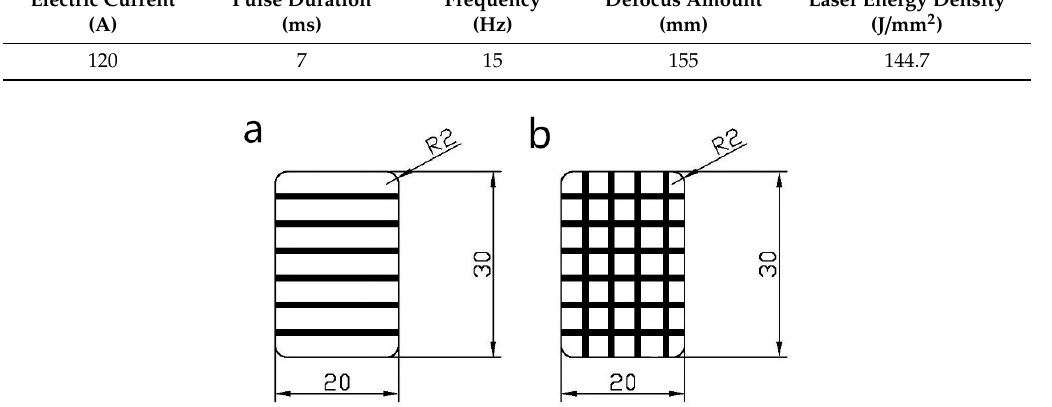
Figure 3. Biomimetic unit model. ( a ) The stripe biomimetic cell model; ( b ) the mesh biomimetic cell model.